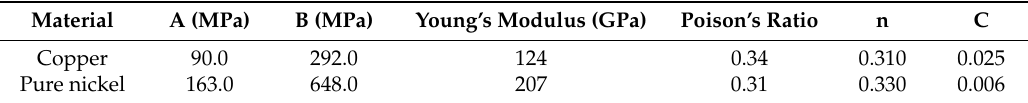
Figure 3. The structure of the Cu/Ni laminated composite metal sheets. Table 1. The mechanical properties of copper and pure nickel.